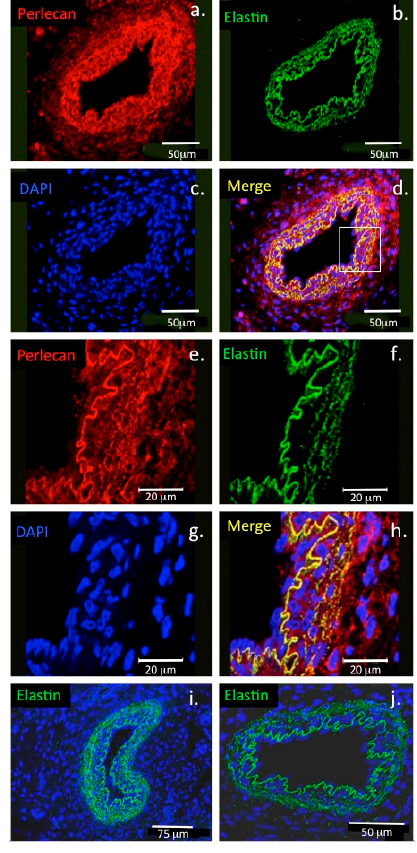
Figure 6. Colocalisation of perlecan and elastin in blood vessels. Confocal immunofluorescence localisations of perlecan and elastin in the basement membrane of a paraspinal blood vessel from a 14-week-old human foetal spinal specimen ( a – d ). Perlecan (red) and elastin (green) are colocalised (yellow) at the lumenal surface of the endothelial cell basement membrane of the blood vessel. The boxed area in ( d ) is shown at higher magnification in ( e – h ). ( i , j ) Elastin immunolocalisations are also shown in an additional paraspinal capillary ( i ) and in a venule ( j ). Cell nuclei depicted with DAPI staining (blue). Image reproduced from [54].